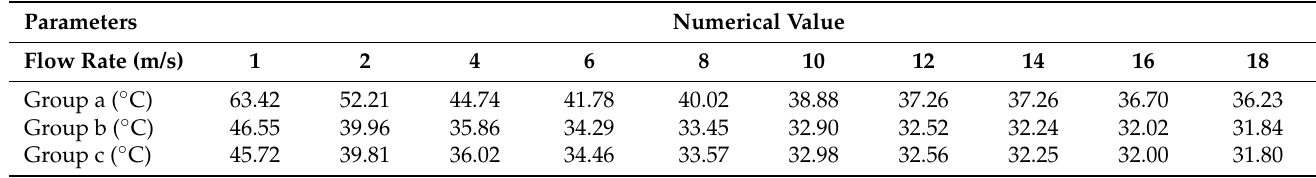
Table 1. Maximum static temperature values of three water-cooled plate surfaces at different inlet flow rates.